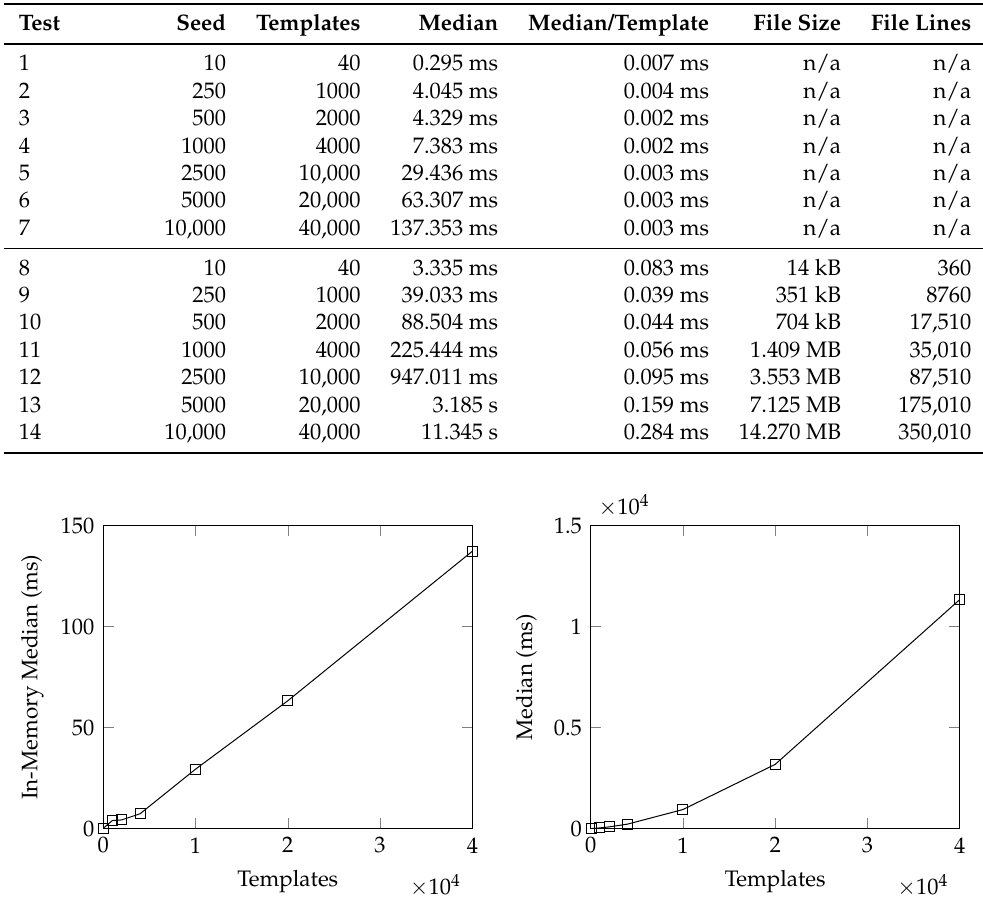
Figure 6. Benchmark results of the Variability Resolver prototype (on the left in-memory, on the right with filesystem interaction and YAML